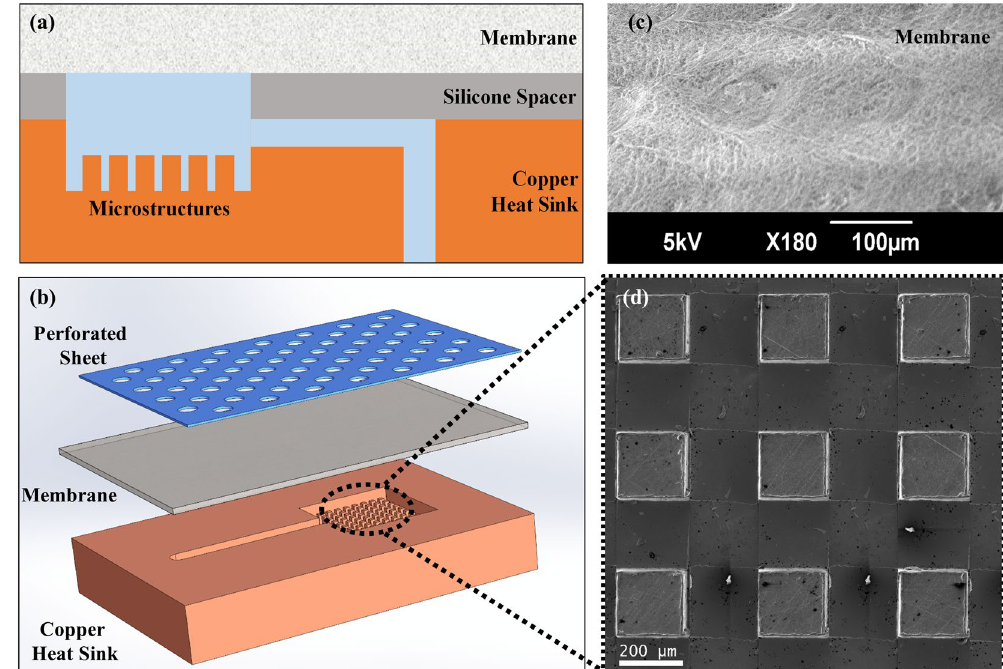
Figure 2. Schematic of test device showing ( a ) cross sectional view of copper base plate, silicone spacer and hydrophobic PTFE membrane and ( b ) isometric view of the device assembly; and SEM micrograph of ( c ) PTFE membrane and ( d ) a surface